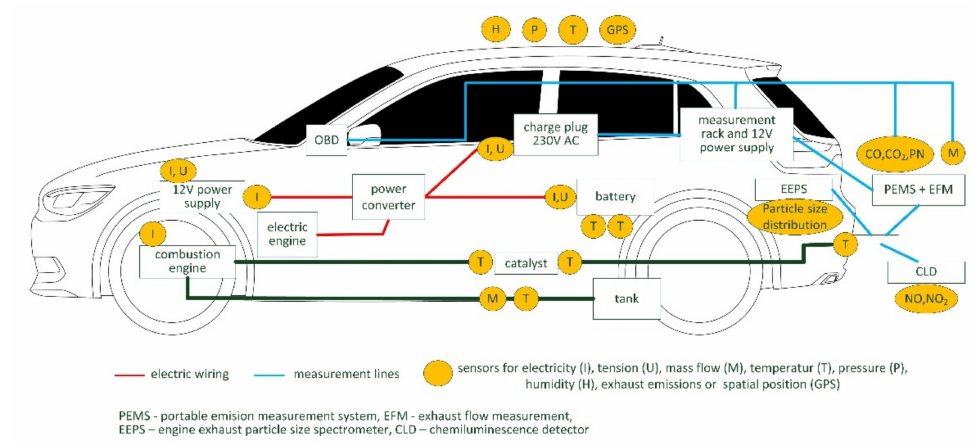
Figure 2. Schematic overview of the measurement arrangement.